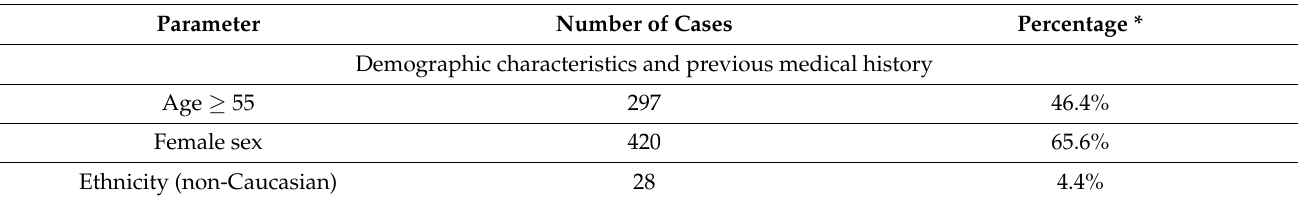
Table 1. Baseline characteristics of the final